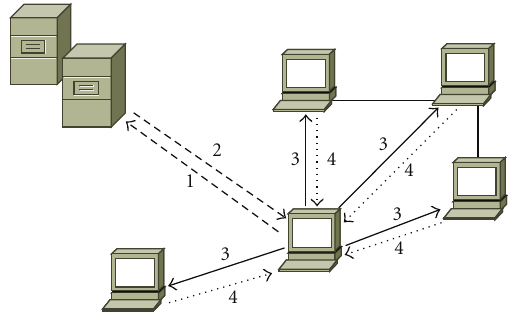
Figure 1: P2P-VOD system: 1: contact server; 2: receive peer list; 3: create application level connections; 4: send